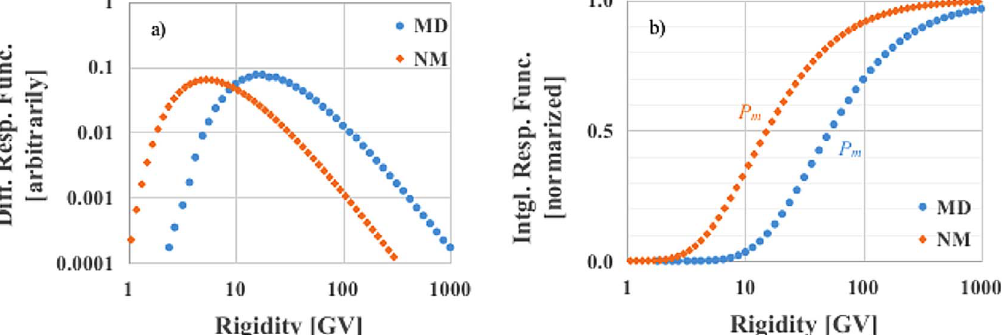
Figure A1. (a) Differential and (b) integral response functions of the muon detector (solid blue circles) and neutron monitor (solid orange diamonds) at Syowa Station. Differential integral response functions are normalized.